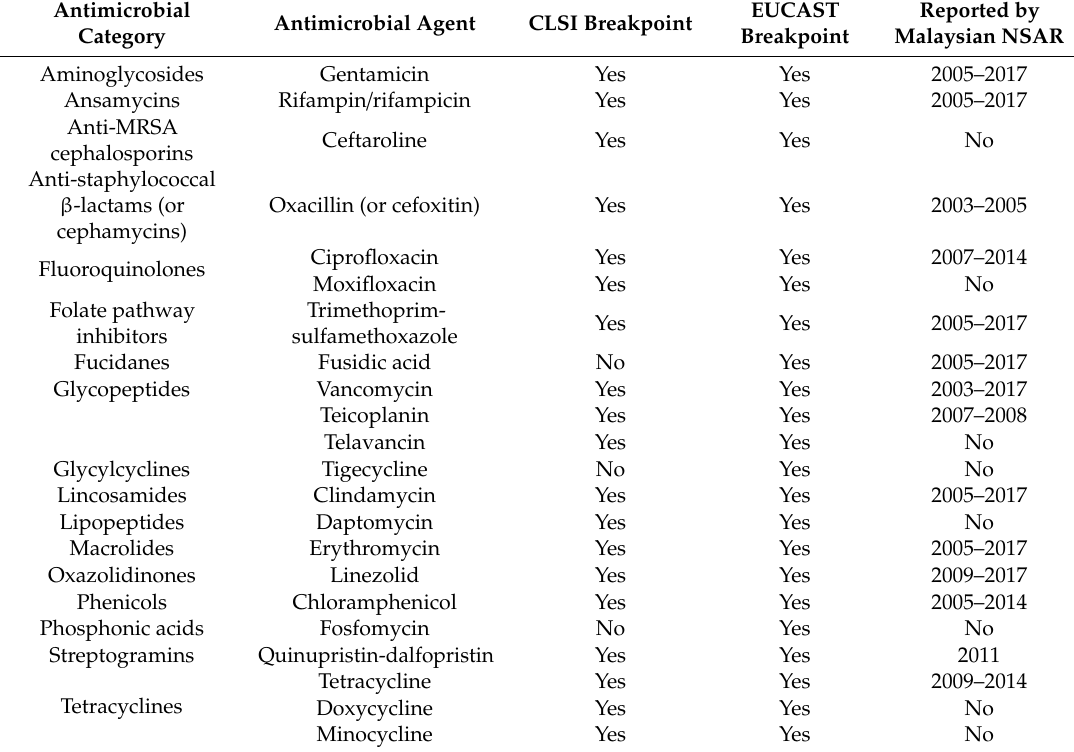
Table 1. List of antimicrobials recommended by the joint commission of the European Centre for Disease Prevention and Control (ECDC) and the United States Centers for Disease Control and Prevention (CDC) for antimicrobial susceptibility testing of S. aureus [11]. The availability of standard breakpoints for the antimicrobials from CLSI or EUCAST and the antimicrobials reported by the Malaysian National Surveillance on Antimicrobial Resistance (NSAR) reports are indicated.